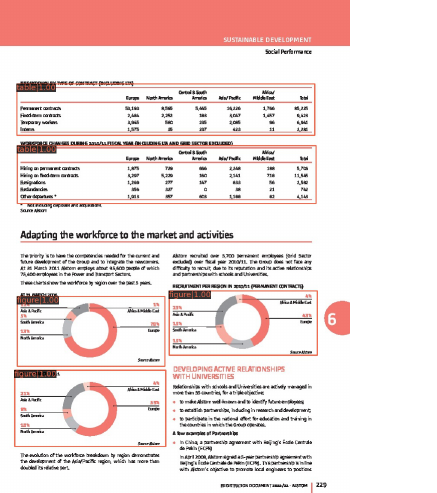
Figure 1. Left : graphical objects Figure, Text and Title. Right : graphical objects Table, List Text and Title. Both the images are generated by the Soft Teacher model, which is trained on 10% of the labeled PubLayNet data.